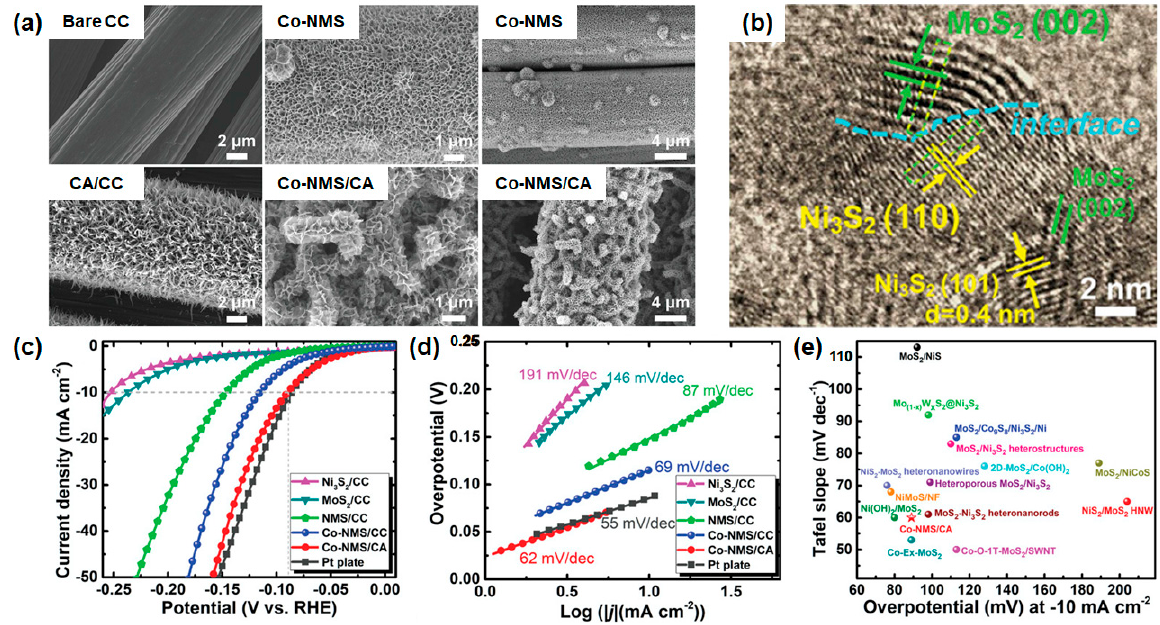
Figure 8. ( a ) SEM images of bare CC, Co-NMS/CC, CA/CC, and Co-NMS/CA. ( b ) HRTEM image of Co-NMS. ( c ) LSV curves of HER for various electrocatalyst samples and ( d ) corresponding Tafel slopes. ( e ) Comparison of the overpotential at − 10 mA/cm 2 and Tafel slope on various representative MoS 2 -based HER electrocatalysts in alkaline electrolyte. Reprinted (adapted) from reference [156], copyright (2021) Wiley-VCH